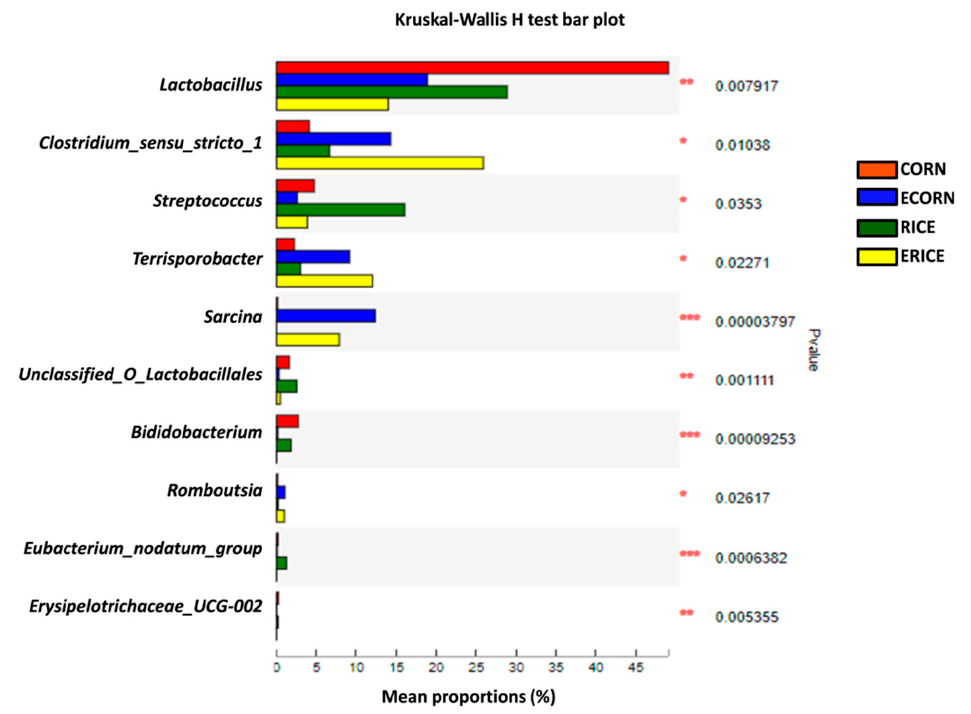
12 of 19 Figure 5. Analysis for differential bacteria at the Phylum level among four dietary treatments. Treatments were corn as the main cereal type (CORN), or half of the corn replaced by extruded corn (ECORN), broken rice (RICE), and extruded broken rice (ERICE), respectively. n = 8. The genera displaying significant effects by cereal type or extrusion process are shown (Figure 6). Kruskal–Wallis analyses were used to compare microbial composition